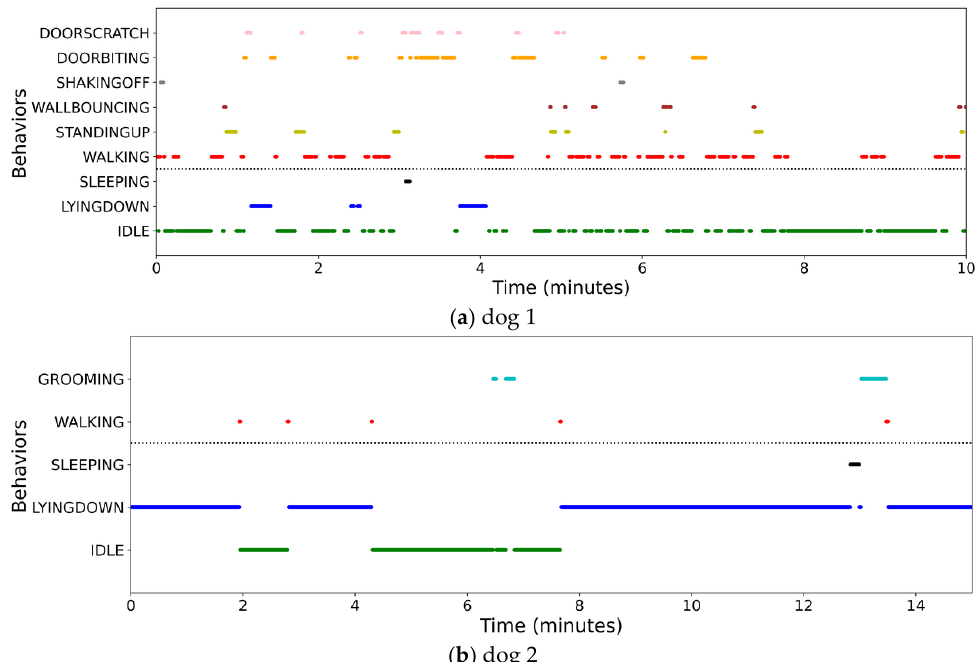
Figure 11. Timeline for visualization of activity and resting behaviors displayed by a dog: ( a ) example of scenario with dog 1; ( b ) example of scenario with dog 2.